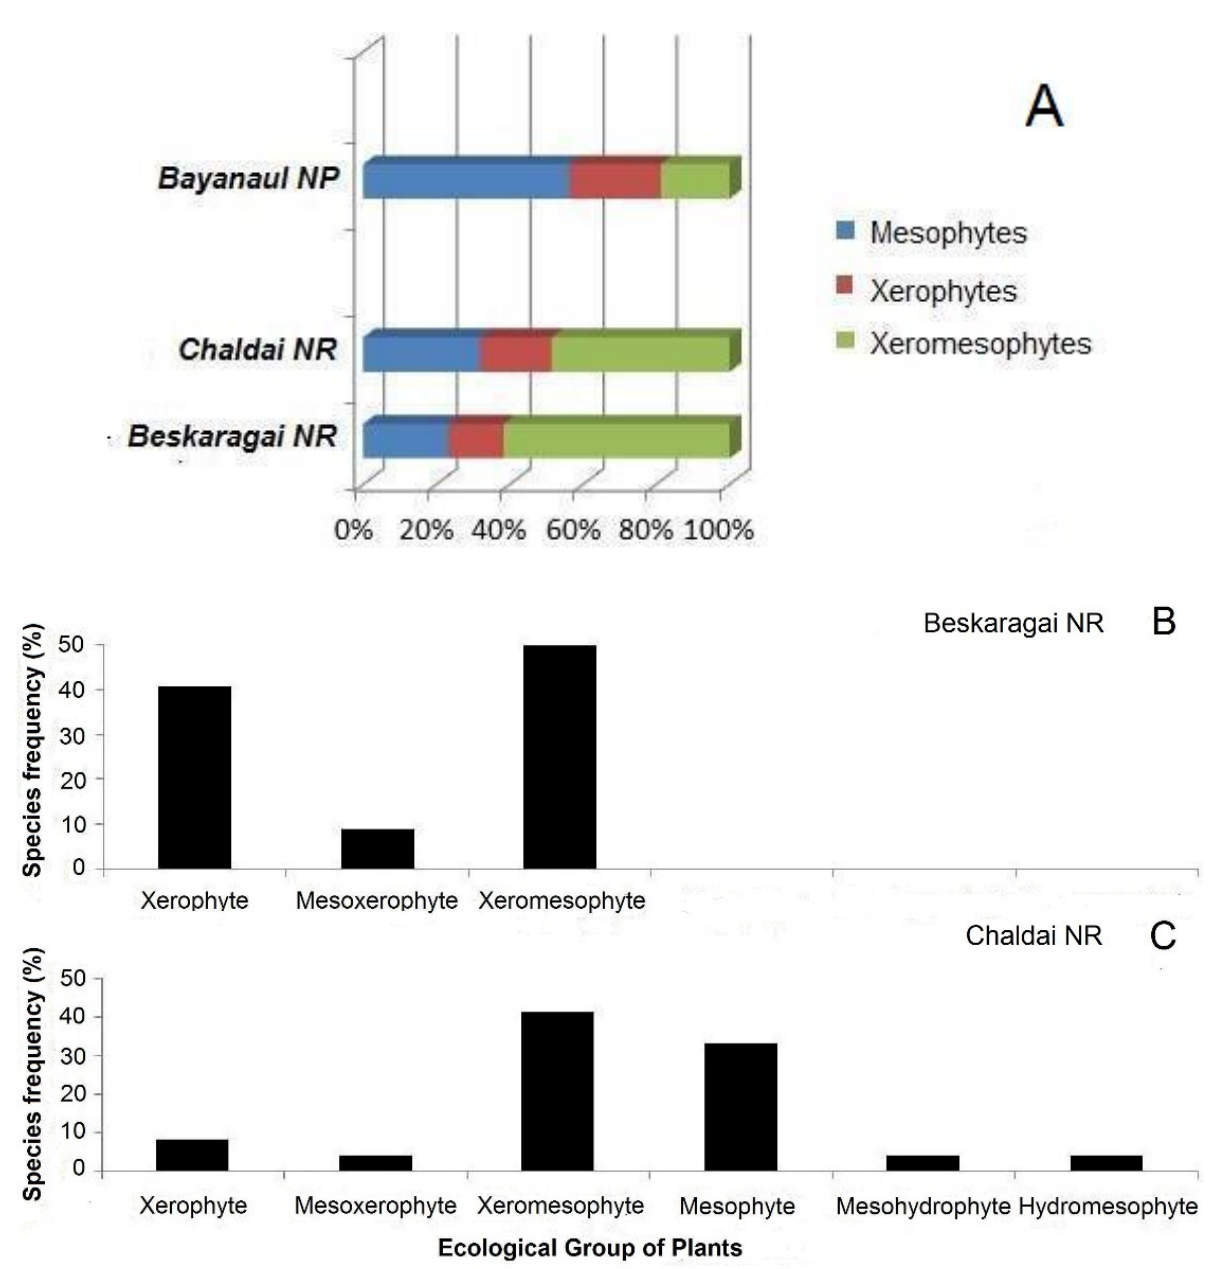
Figure 5. Ecological groups of plants of the broader area within the Bayanaul Nature Park, the Chaldai and Beskaragai Nature Reserves ( A ); and the Beskaragai upland pine forest ( B ) and the Chaldai plain pine forest ( C ).